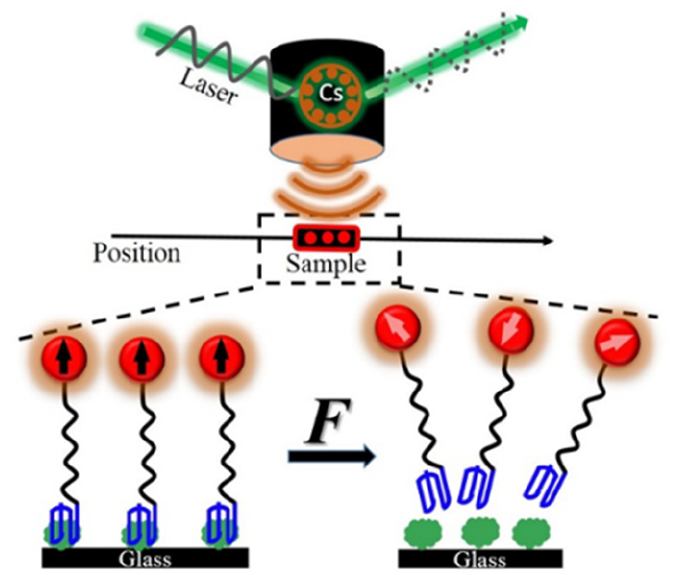
Figure 1. Schematic principle of FIRMS.